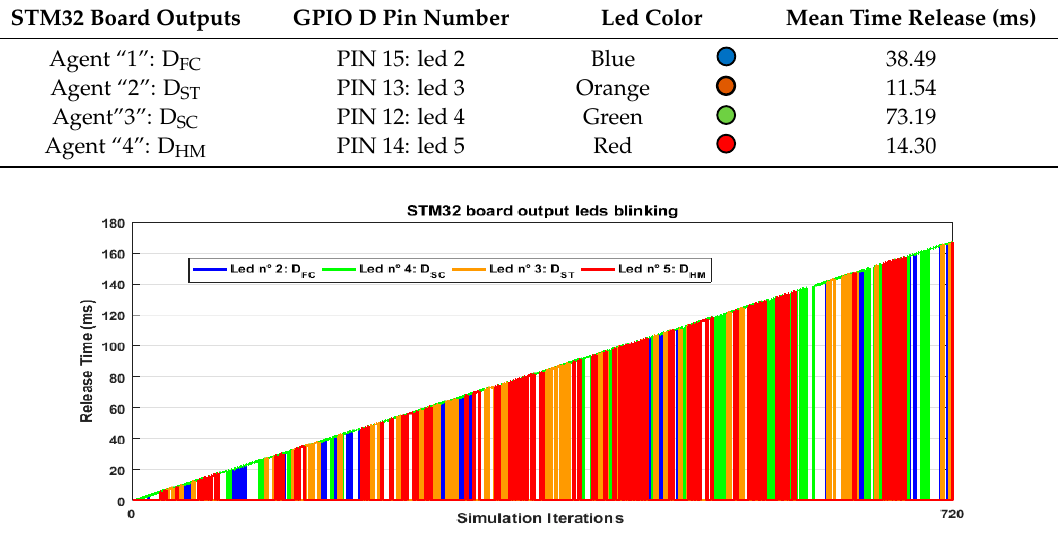
Figure 13. STM32 board led blinking time.